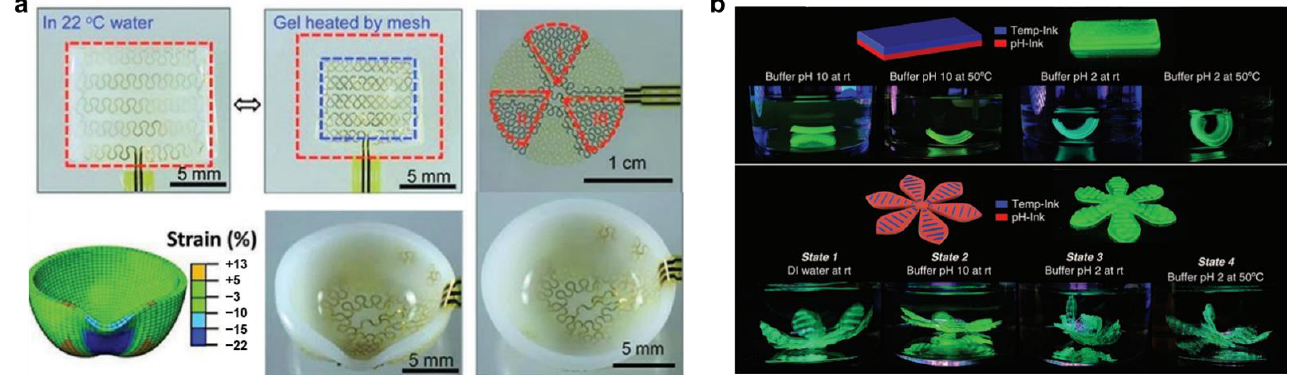
Figure 9. Multi-material 4D printing for shape transformation combining hard and soft materials. ( a ) heating elements are patterned into a soft thermo-responsive hydrogel. Adapted with permission from [139]. Copyright © 2013 Wiley. ( b ) Multi-ink printed hydrogels with different responsiveness such as temperature, pH, and enzymatic response. Adapted with permission from [140]. Copyright © 2021